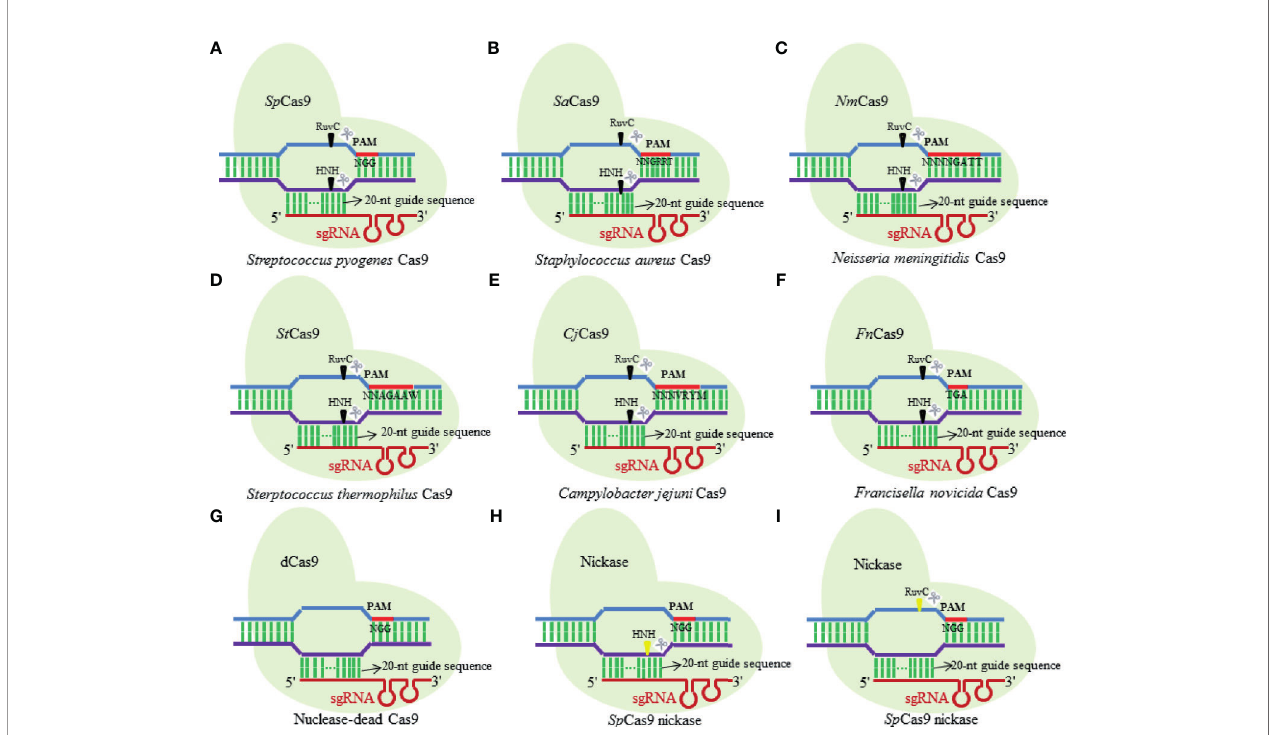
FIGURE 1 | Diagram illustrating several structural variants and orthologues of natural Cas9 nuclease. (A) Streptococcus pyogenes Cas9; (B) Staphylococcus aureus Cas9; (C) Neisseria meningitidis Cas9; (D) Sterptococcus thermophilus Cas9; (E) Campylobacter jejuni Cas9; (F) Francisella novicida Cas9; (G) nuclease-dead Cas9; (H) SpCas9 nickase; (I) SpCas9